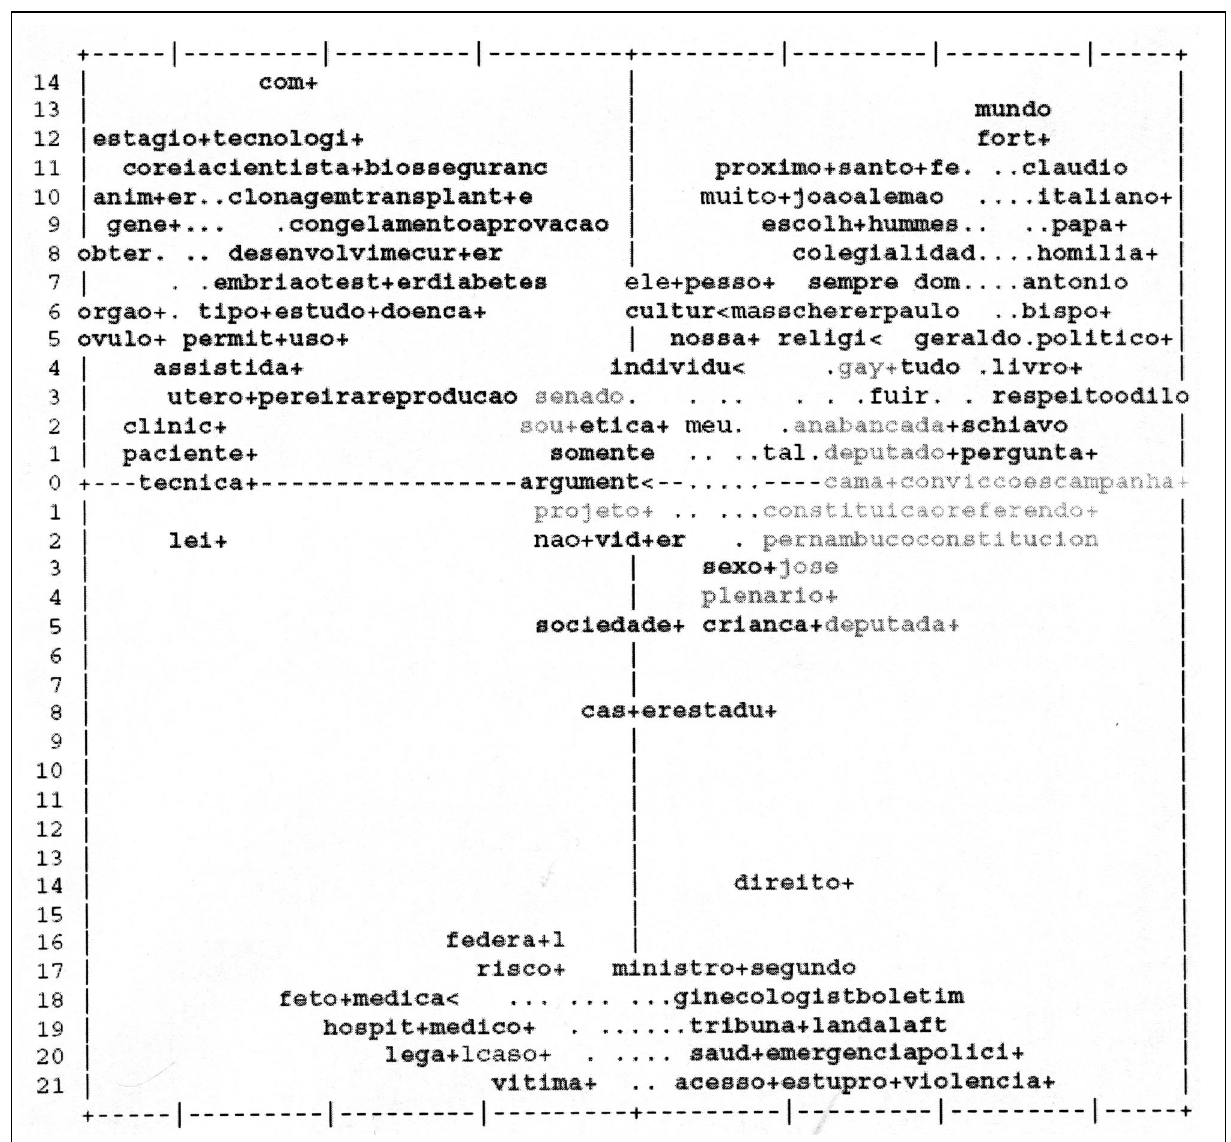
Figura 2. Gráfico resultante da análise fatorial de correspondência efetuada pelo